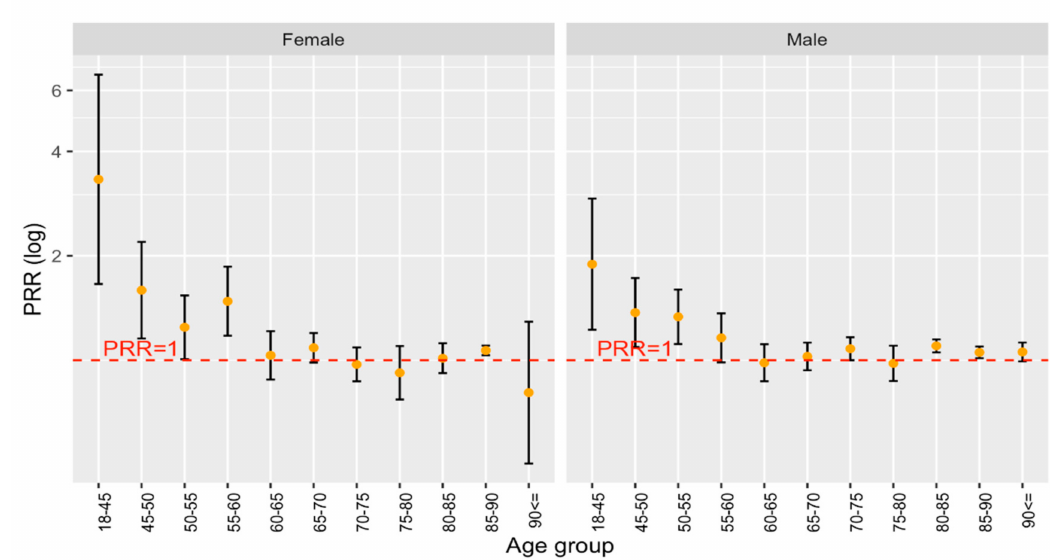
Figure 2. PRR for Arterial Hypertension by Age group and Sex in Stroke Patients.